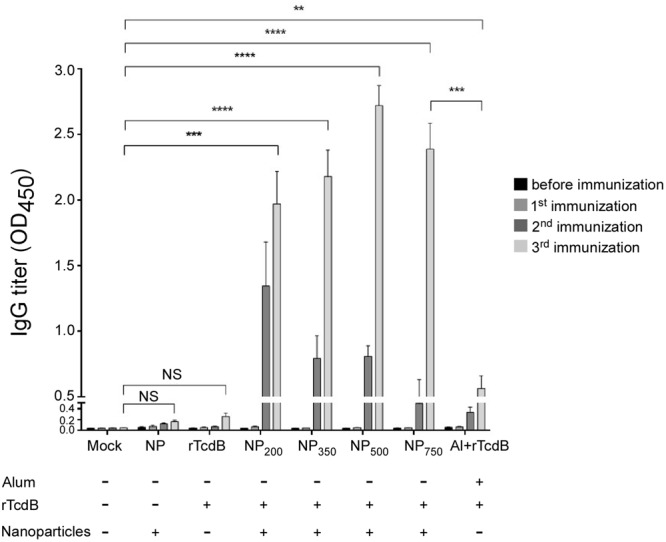
Induction of antigen-specific IgG in nanoparticle vaccinated mice. ELISA was performed in triplicate using coated peptide pool. Serum IgGs (1:20,000 dilution) in differentially immunized mice were compared. Mock: PBS injection only; NP: empty nanoparticle infection; rTcdB: injection with 20 μg purified rTcdB in PBS. NP200, NP350, NP500, and NP750: injection with NP-rTcdBs with the corresponding size in nanometers; Al+rTcdB: injection with 20 μg purified rTcdB mixed with Alum. All data are presented as mean ± standard deviations and statistical comparisons among groups were analyzed by Student’s t-test and ANOVA (∗∗p ≤ 0.01, ∗∗∗p ≤ 0.001, ∗∗∗∗p ≤ 0.0001). NS, not significant. All data are representative of at least three independent experiments.